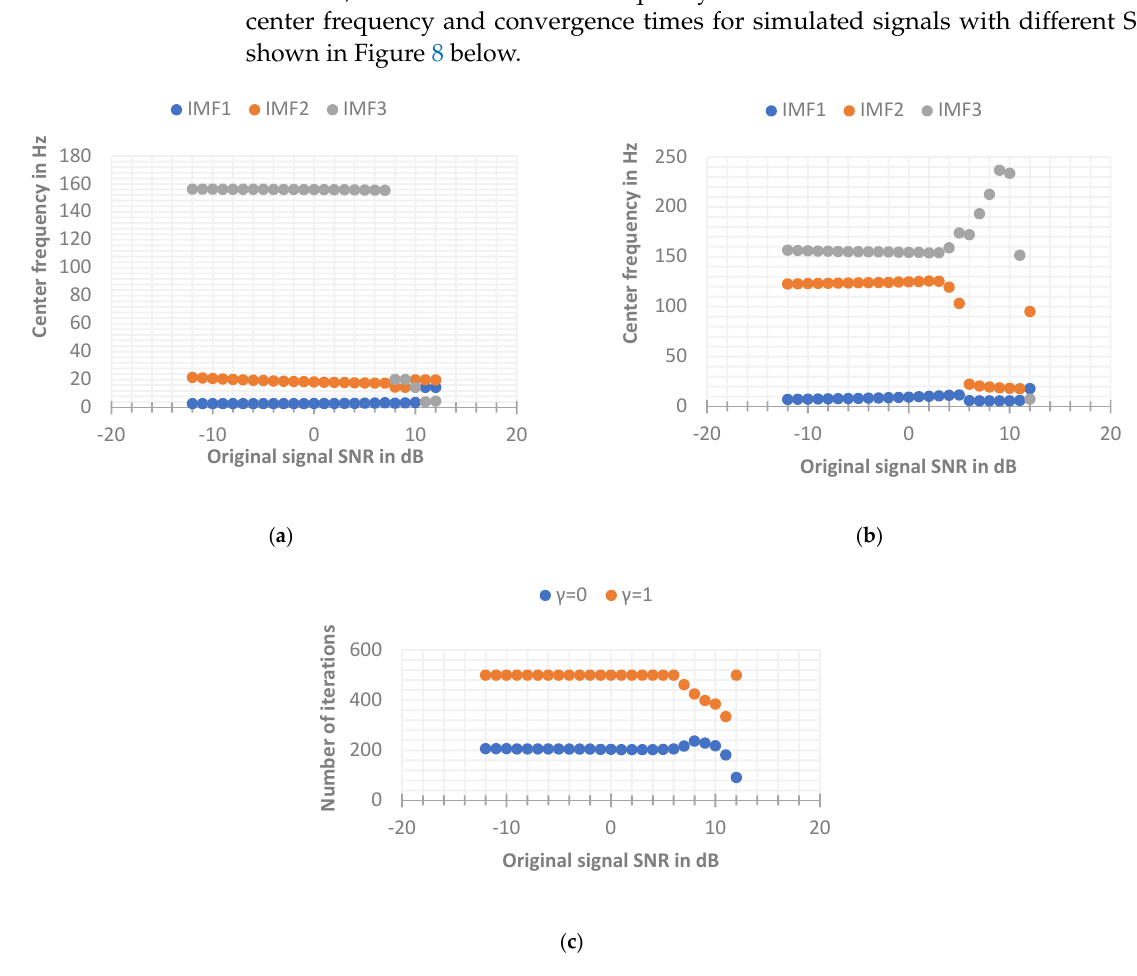
Figure 8. The final convergence center frequency and convergence times of the simulated signal with the initial center frequency is set to 0. ( a ) The components at γ = 0 eventually converge to the central frequency. ( b ) The components at γ = 1 eventually converge to the central frequency. ( c ) The number of iterations with different values of γ